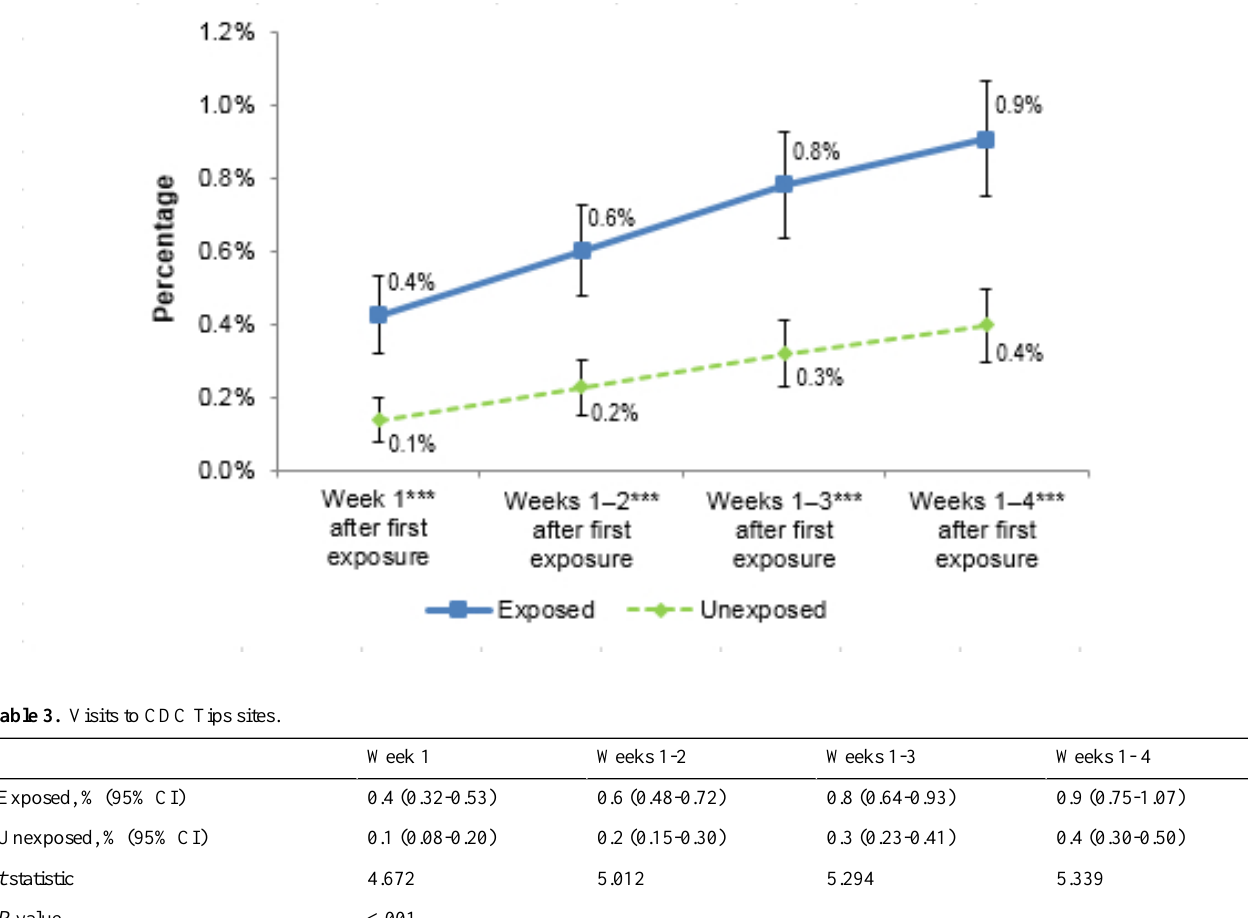
Figure 2. Shows the change in visits to CDC Tips 2012-related websites over the course of the campaign by digital ad exposure.